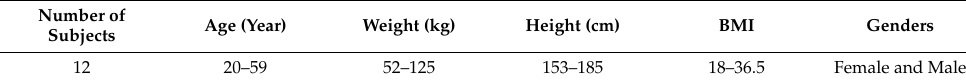
Table 2. Details of subjects whose readings were taken during the test.